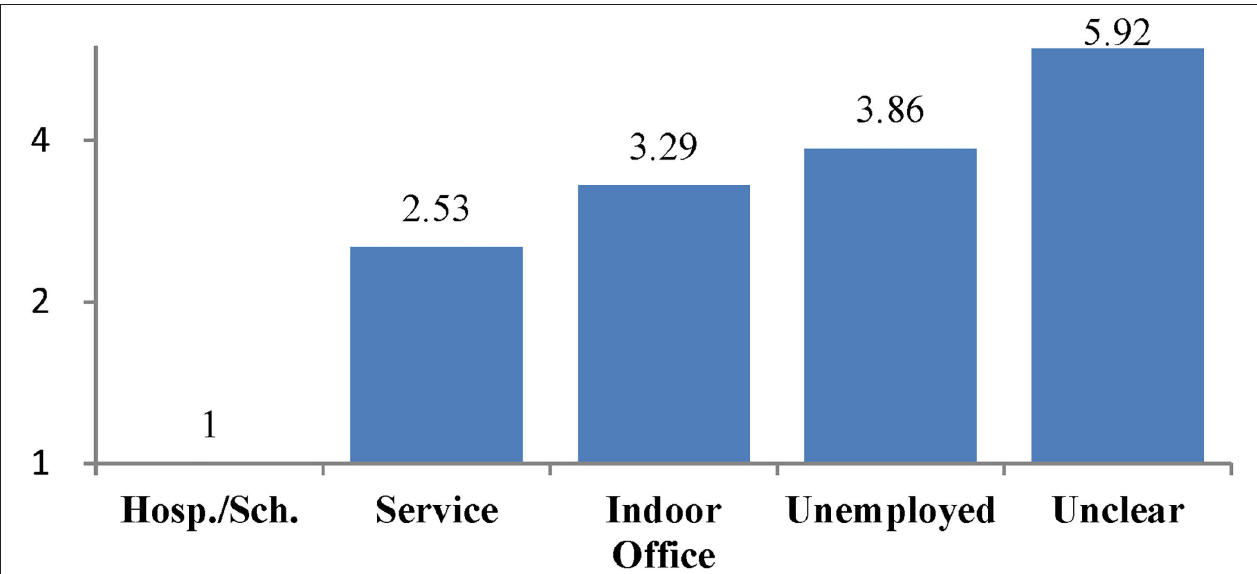
FIGURE 5 | Adjusted relative risk (RR) for